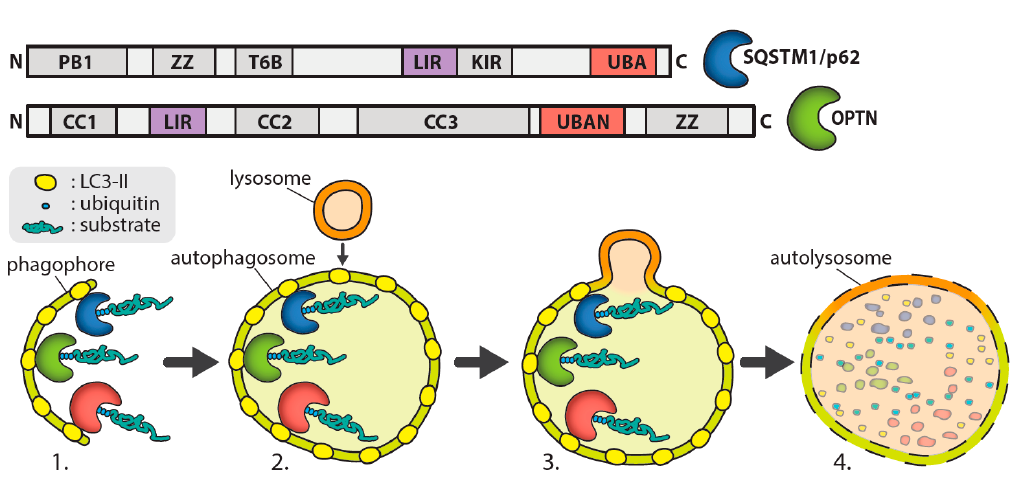
Figure 1. Formation of phagophore in autophagy. The above diagram shows the formation of the double-membraned structure during Macroautophagy. Domains of SQSTM1 / p62; PB1 (Phox and Bemp1), ZZ (zinc finger), T6B (tumour necrosis factor receptor associated factor 6 binding), LIR (LC3 interacting region), KIR (Kelch-like ECH associated protein 1 interacting region), UBA (ubiquitin-associated). Domains of OPTN; coiled coil (CC1-3), LIR, UBAN (ubiquitin-binding domain in ABIN proteins and NEMO), ZZ (ZZ-type zinc finger).